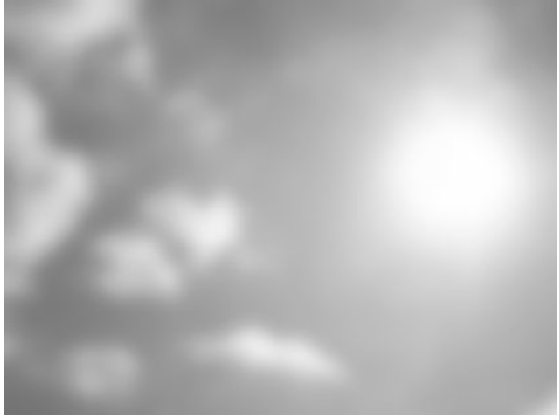
Figure 3. The grayscale image after the Gauss smoothing filter.